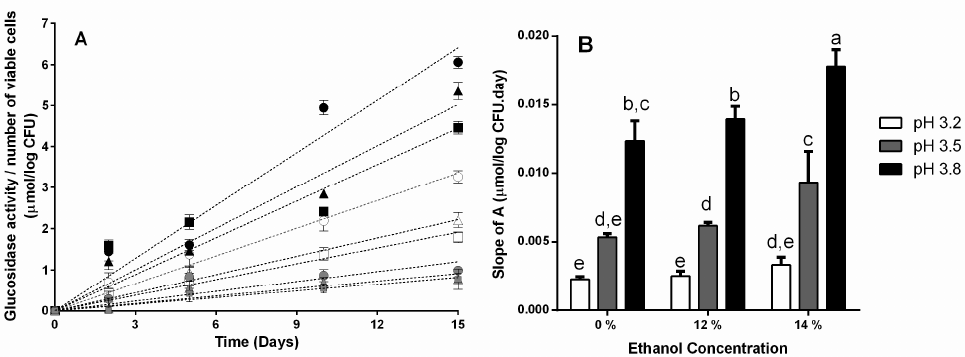
Figure 3. ( A ) β -glucosidase activity of UNQLp 11/log number of viable cells ( µ mol p-NP/log CFU) along time of synthetic wine with different ethanol content (0% (squares), 12% (triangles), and 14% v/v (circles) at different pH values: 3.8 (black symbols), 3.5 (white symbols), and 3.2 (gray symbols). ( B ) Slope of linear regression obtained from Figure 3A. White bars: pH 3.2; gray bars: pH 3.5, and black bars: pH 3.8. Different letters (a, b, c, d, e) represent groups with significant differences ( p < 0.05). The statistical analysis was done with ANOVA and posterior Tukey test.